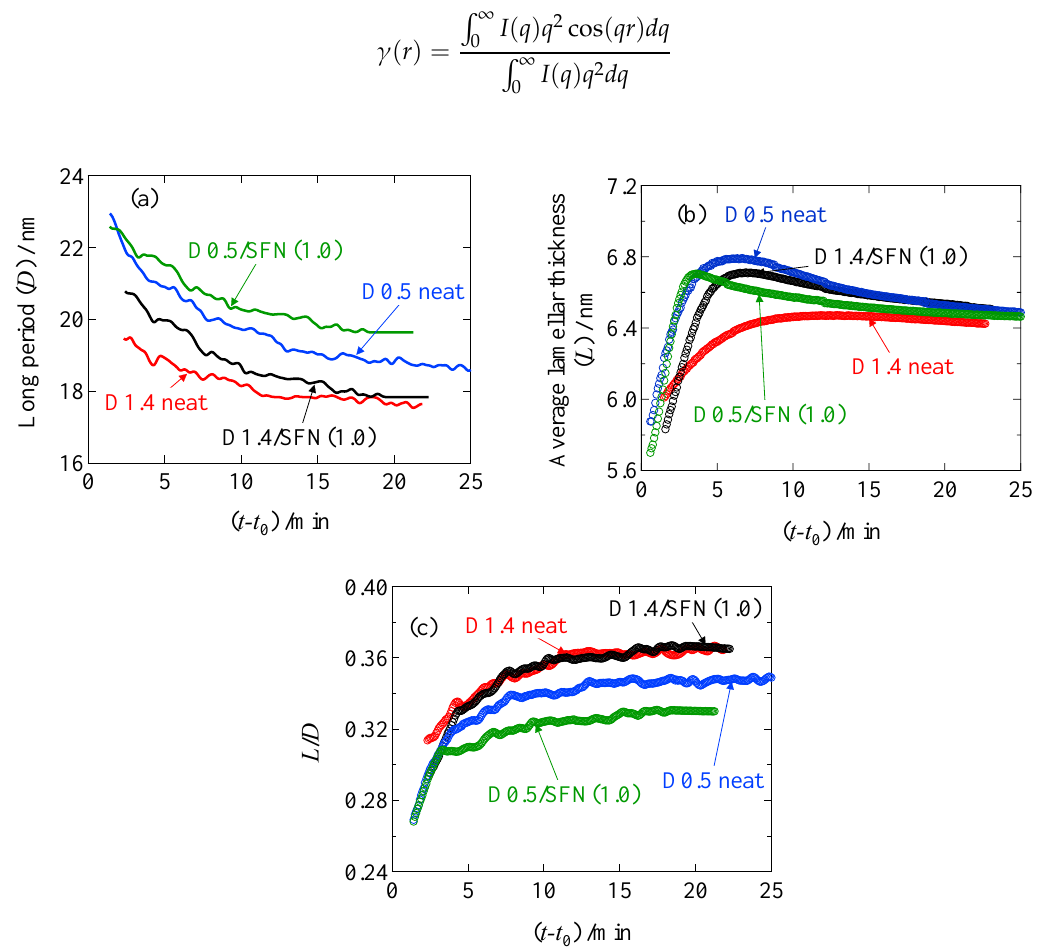
Figure 9. (a) Long period ( D ), (b) average lamellar thickness ( L ), and (c) L / D as a function of ( t − t 0 ), where t 0 is the induction period.